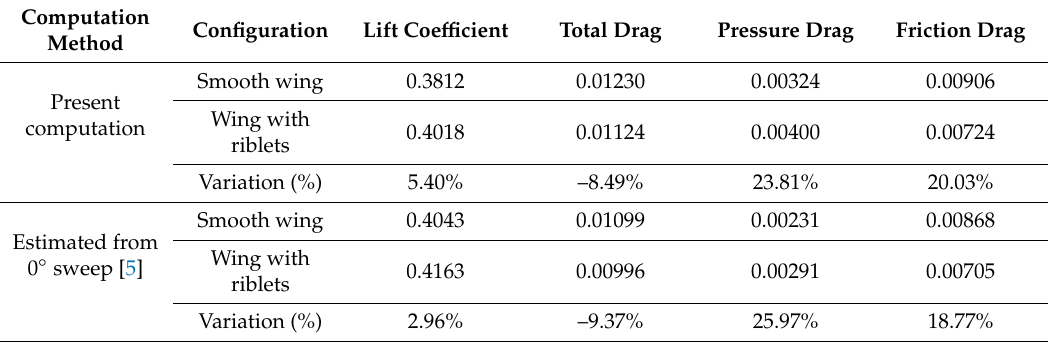
Table 2. Averaged force coe ffi cients of the wing without and with